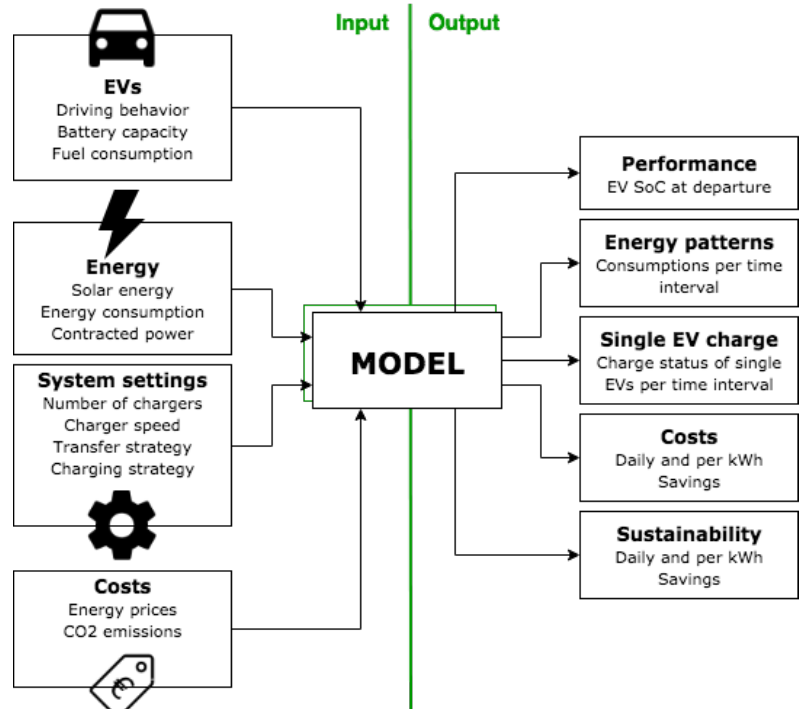
Figure 7. VeCS model inputs and outputs.